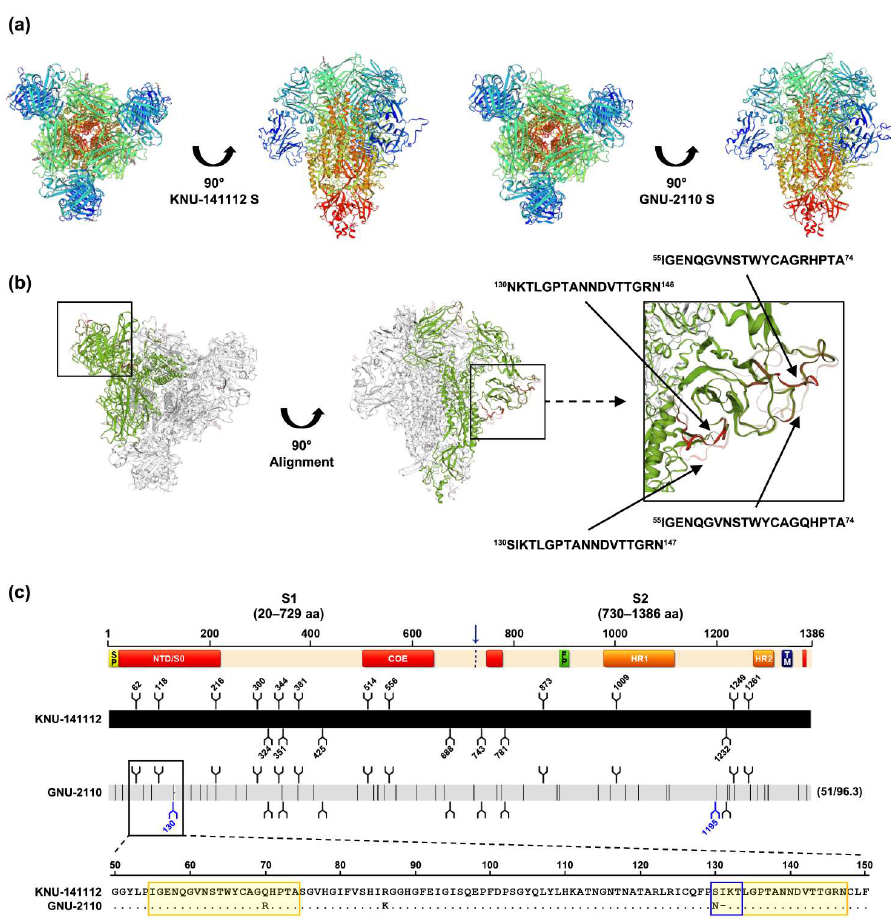
Figure 8. 3D structural modeling and sequence alignment of KNU-141112 S and GNU-2110 S51. ( a ) 3D models of the S structure of KNU-141112 and GNU-2110. The predicted S glycoprotein 3D struc- tural models were generated and observed at the top (left) and front (right) sites. ( b ) 3D structural alignment of S between KNU-141112 and GNU-2110. The 3D structures of the two S proteins were aligned and observed on the top (left) and front (right) sites. The region showing structural varia- tions in the S protein between KNU-141112 and GNU-2110 is boxed, and its enlarged version is presented on the right. The residues with structural variations are shown in gray for KNU-141112 and magenta for GNU-2110. ( c ) Schematic diagram of genetic variations in the S gene between KNU- 141112 and GNU-2110, showing the predicted positions of N-linked glycosylation. The top illustra- tion represents the organization of the S protein, featuring S1 and S2 subunits that contain a signal peptide (SP), an N-terminal hypervariable domain (NTD), a fusion peptide (FP), heptad repeat re- gions (HR1 and HR2), and a transmembrane domain (TM). Red-highlighted areas in the diagram